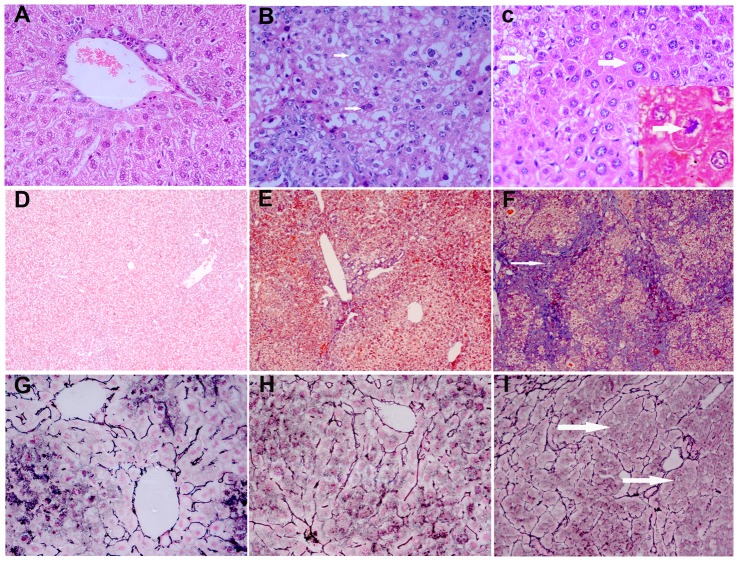
Pathological changes of liver in 3 groups mice at 35-week.A–C: Light microscopy of H&E staining in control group, Maotai+ DEN group and ethanol+ DEN group (400× magnification). Hepatocyte ballooning degeneration, edema and regeneration could be seen in Maotai+ DEN group, The lobular structure of hepatocytes in ethanol+ DEN group was destroyed with fatty degeneration, bridging necrosis, hepatocytes abnormal fission, atypical hyperplasia in ethanol+ DEN group; D–F: Light microscopy of Masson staining in control group, Maotai+ DEN group and ethanol+ DEN group (100×magnification).As the arrow indicate, significant liver fibrosis and pseudolobule formation in ethanol+ DEN group, but only moderate fibrosis formation in Maotai+ DEN group; G–I: Light microscopy of reticulin fiber staining in control group, Maotai+ DEN group and ethanol+ DEN group (400×magnification).Arrows indicate liver tissue structure obvious change and “floating trabeculae” in ethanol+ DEN group, but was normal in Maotai+ DEN group.